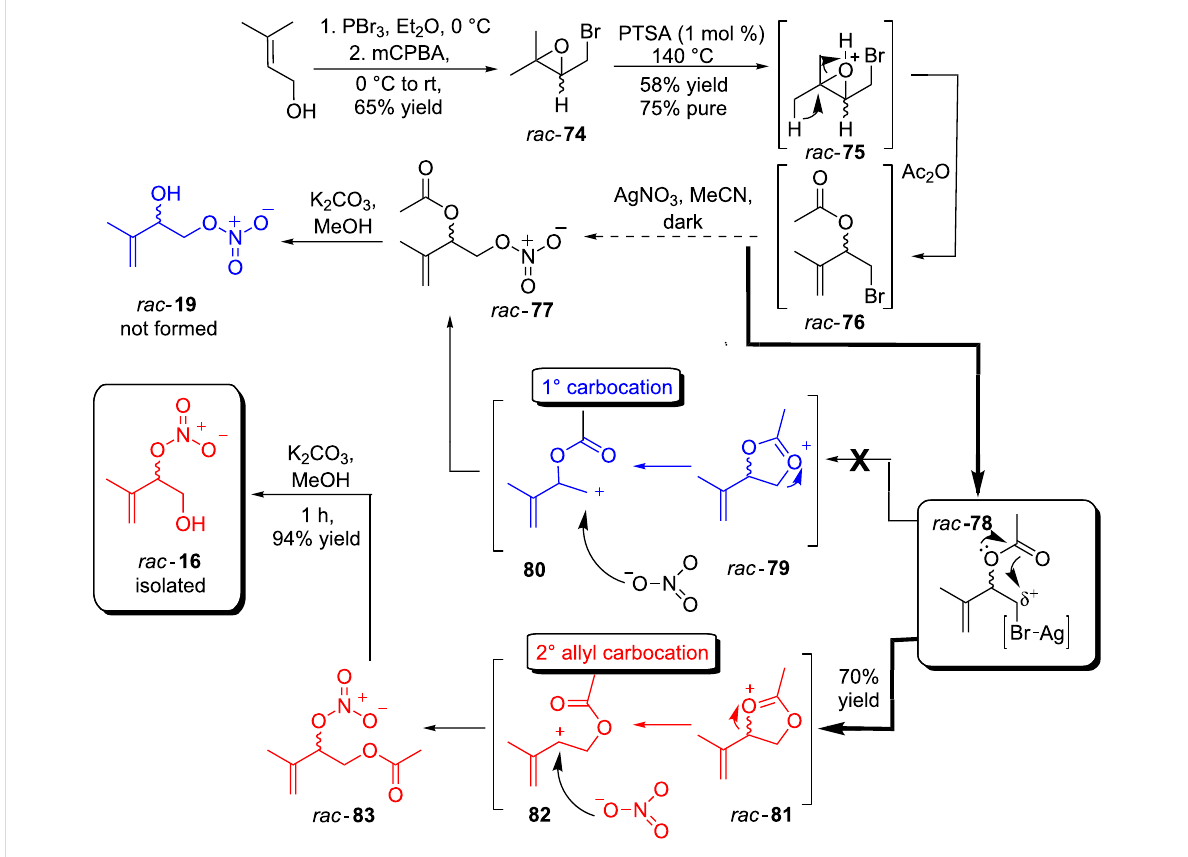
Scheme 13: Attempted synthesis of 2° alcohol containing 1° nitrate ester rac - 19 and the unexpected synthesis of (±)-1-hydroxy-3-methylbut-3-en-2-yl nitrate, rac - 16 .